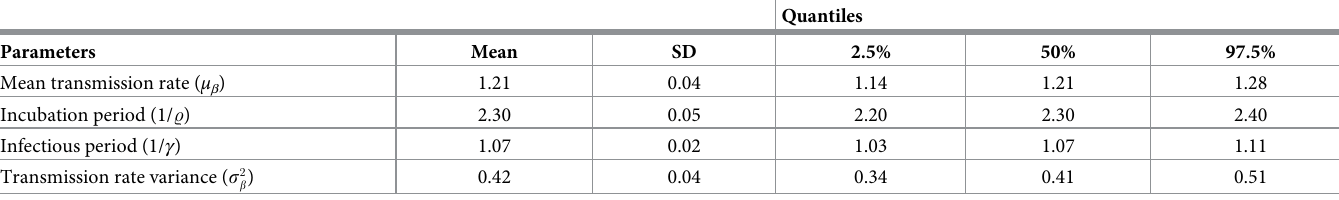
the incubation period and the infectious period are common for all the